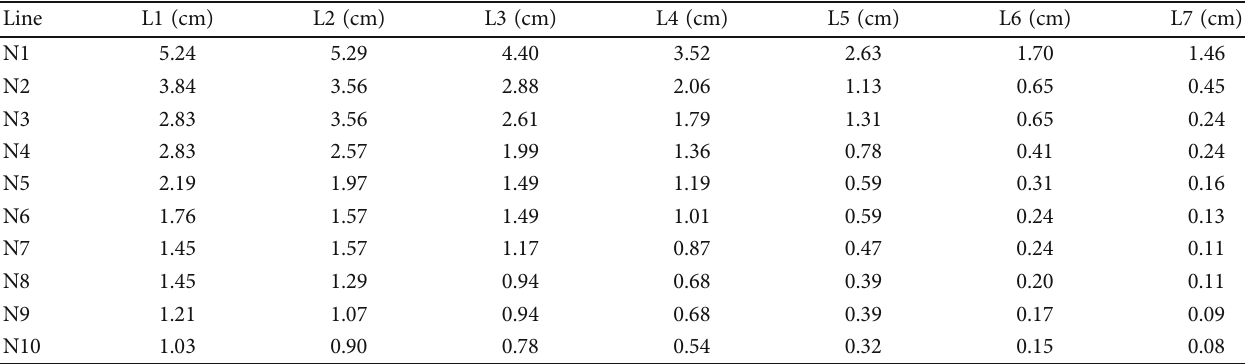
Table 2: The radial displacements of each survey